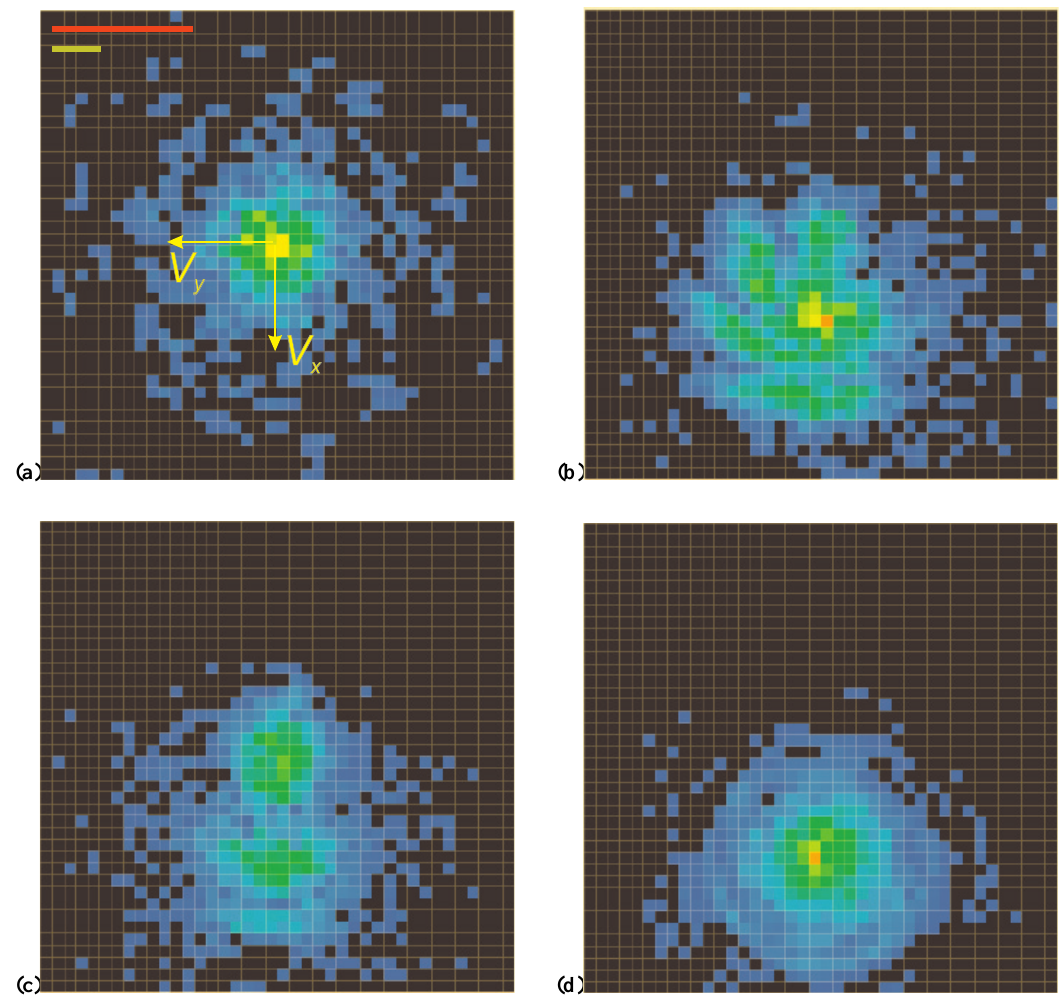
Fig. 2. Examples of distribution functions: phase space densities at v z = 0; v x = v y = 0 at the center of each plot. (a) Initial state at B n /B 0 = 0 . 12, z = 0. (b) Later moment t = 4 /(cid:127) 0 ; B n /B 0 = 0 . 12, z = 0. (c) t = 4 /(cid:127) 0 ; B n /B 0 = 0 . 12, z = 12 . 2 ρ 0 . (d) t = 4 /(cid:127) 0 ; B n /B 0 = 0 . 2, z = 0. The red bar is the value of the hot ions thermal velocity, the green one – that of the cold ions. Density decrease is denoted by the color sequence, from red to blue; black denotes negligible